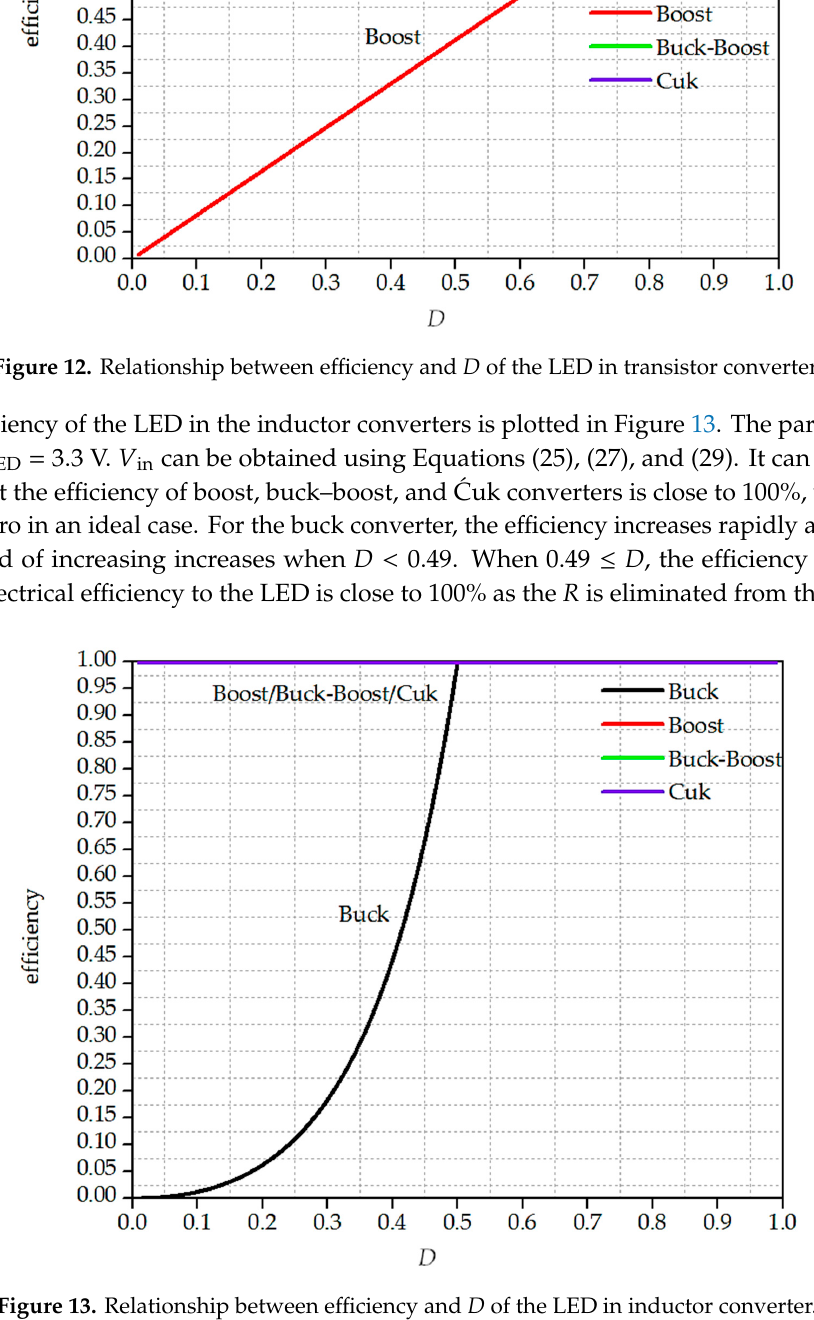
ffi ciency and D of the LED in inductor Figure 13. Relationship between efficiency and D of the LED in inductor converter. Figure 13. Relationship between e